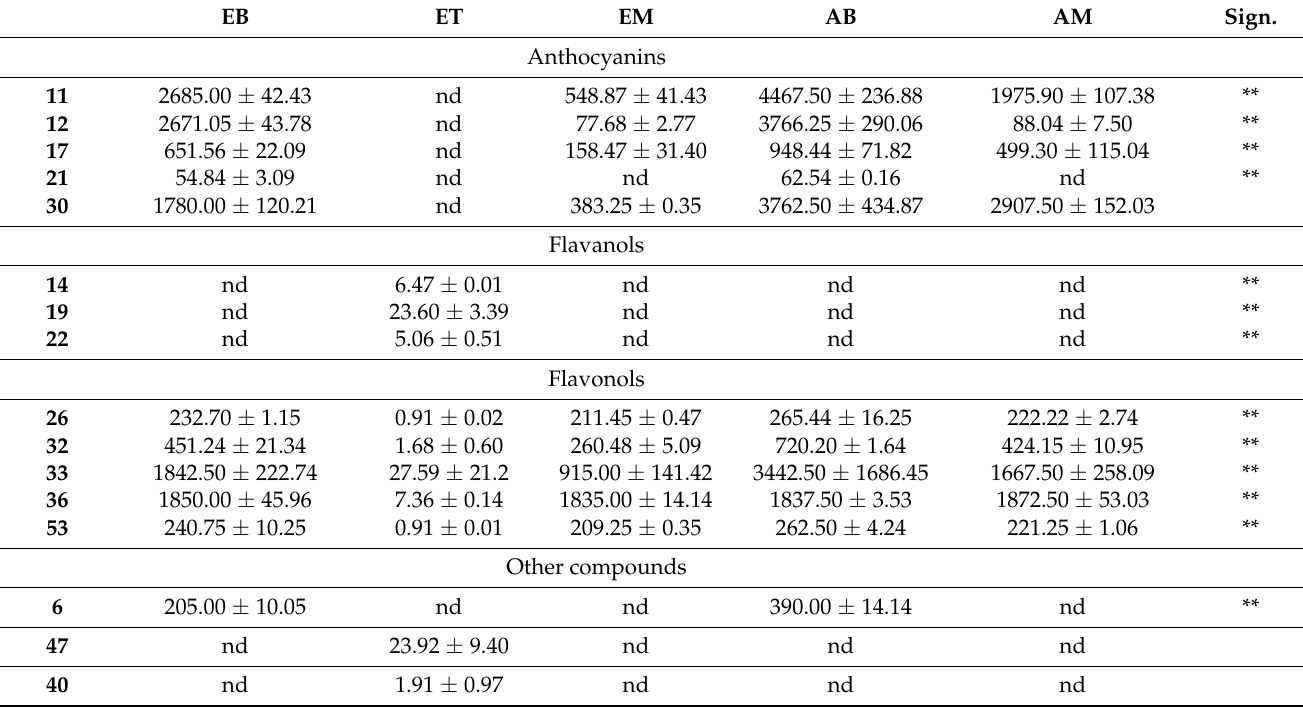
Table 3. Secondary metabolites quantified by UHPLC coupled to Qtrap 6500 (AbSciex).